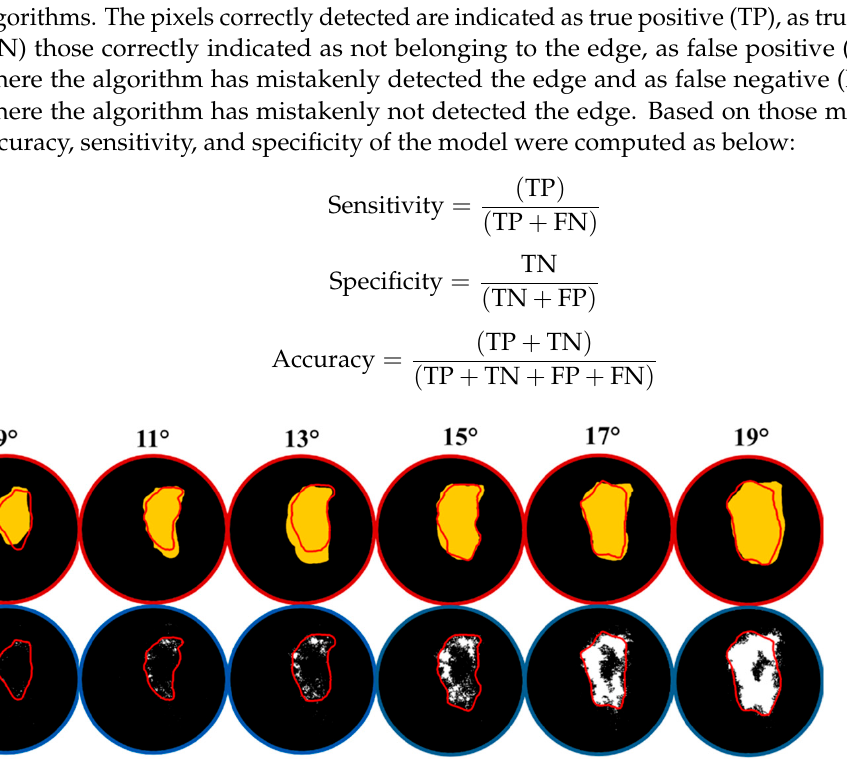
Figure 12. Evaluation of the R eq trends, averaged over 63 cycles, in the three operating condi- tions analyzed, i.e. ( a ) λ =1.4, ( b ) λ =1.55 and ( c ) λ =1.6.